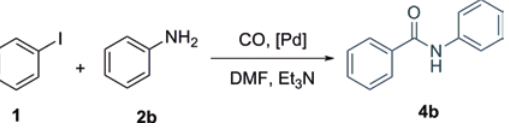
Scheme 2: Aminocarbonylation of iodobenzene ( 1 ) with aniline ( 2b ) as the